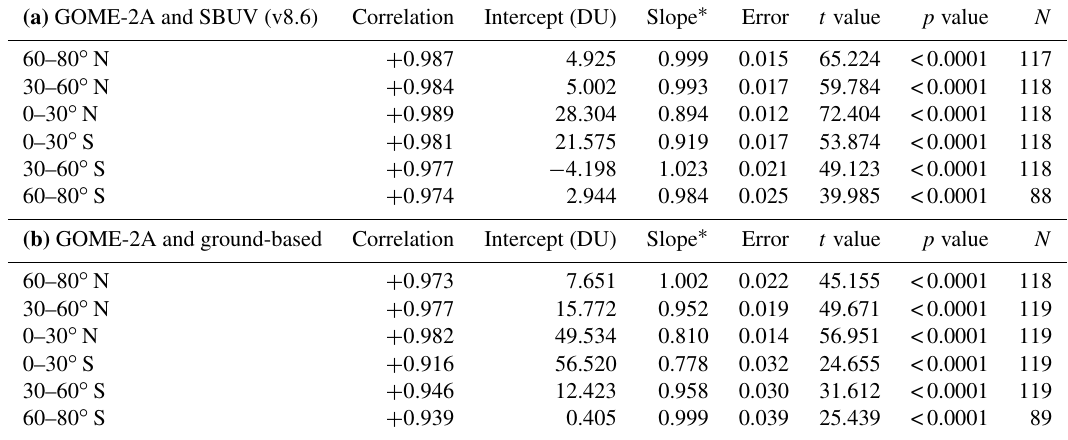
∗ Error, t value, and p value refer to slope.